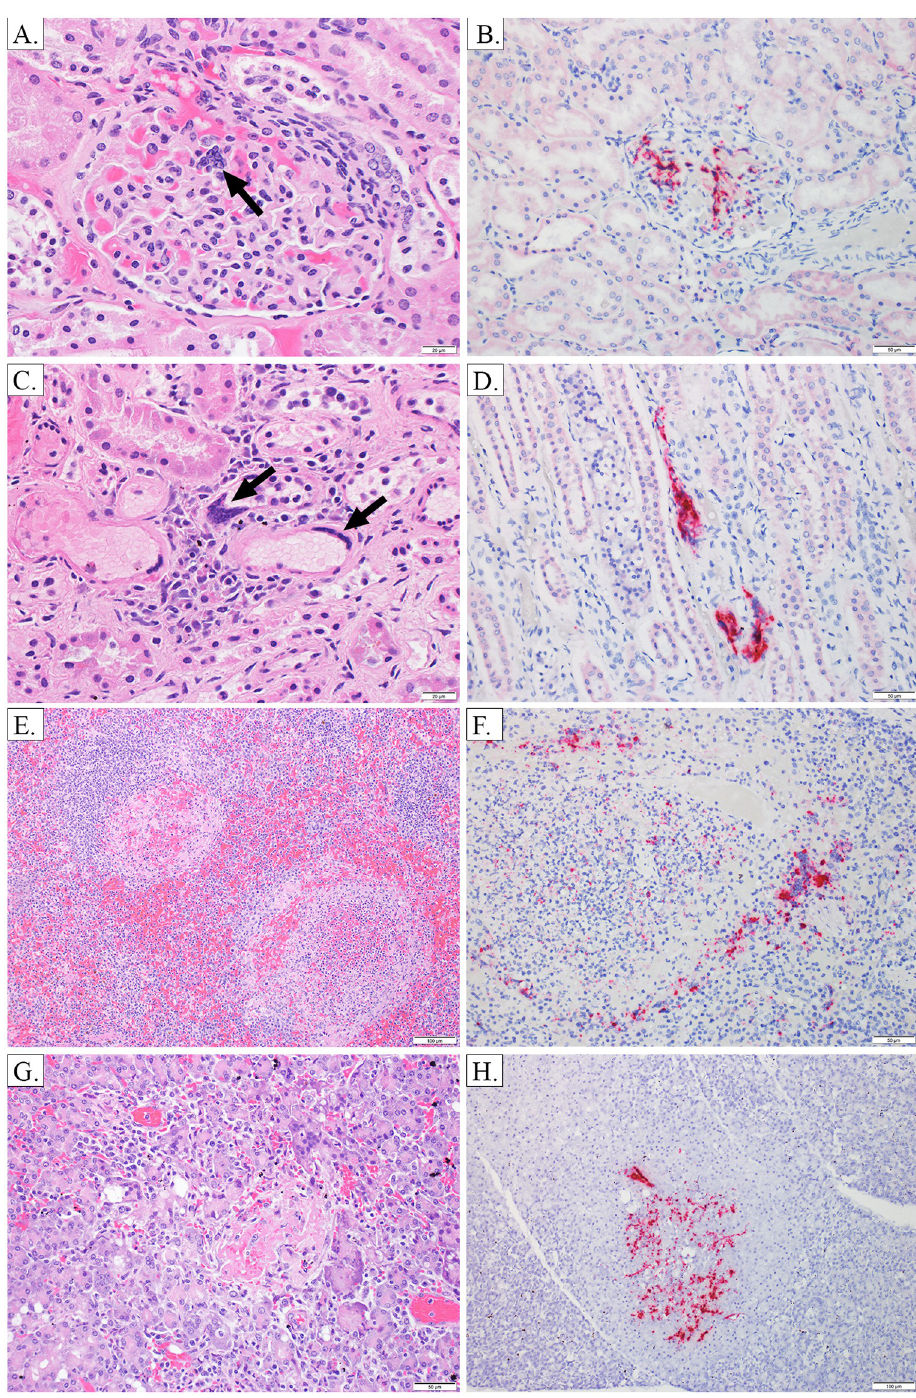
Fig 7. Kidney, spleen, pancreas—H&E and ISH. Image A, AGM 2, kidney 40X H&E: Viral syncytia in the renal glomerulus. Image B, AGM 1, kidney 20X ISH: NiV labeling in the renal glomerulus. Image C, AGM 2, kidney 40X H&E: Viral syncytia in vessels in the renal interstitium. Image D, AGM 2, kidney 20X ISH: NiV labeling in the renal interstitium. Image E, AGM 3, spleen 10X H&E: Multifocal areas of necrosis with abundant fibrin, hemorrhage and inflammation effacing the white pulp architecture. Image F, AGM 1, spleen 20X ISH: NiV labeling within and surrounding areas of necrosis, including in viral syncytia. Image G, AGM 1, pancreas 20X H&E: Focal area of pancreatic degeneration and necrosis with hemorrhage and fibrin. Image H, AGM 1, pancreas 10X ISH: Focal area of NiV labeling corresponding to an area of degeneration/necrosis.